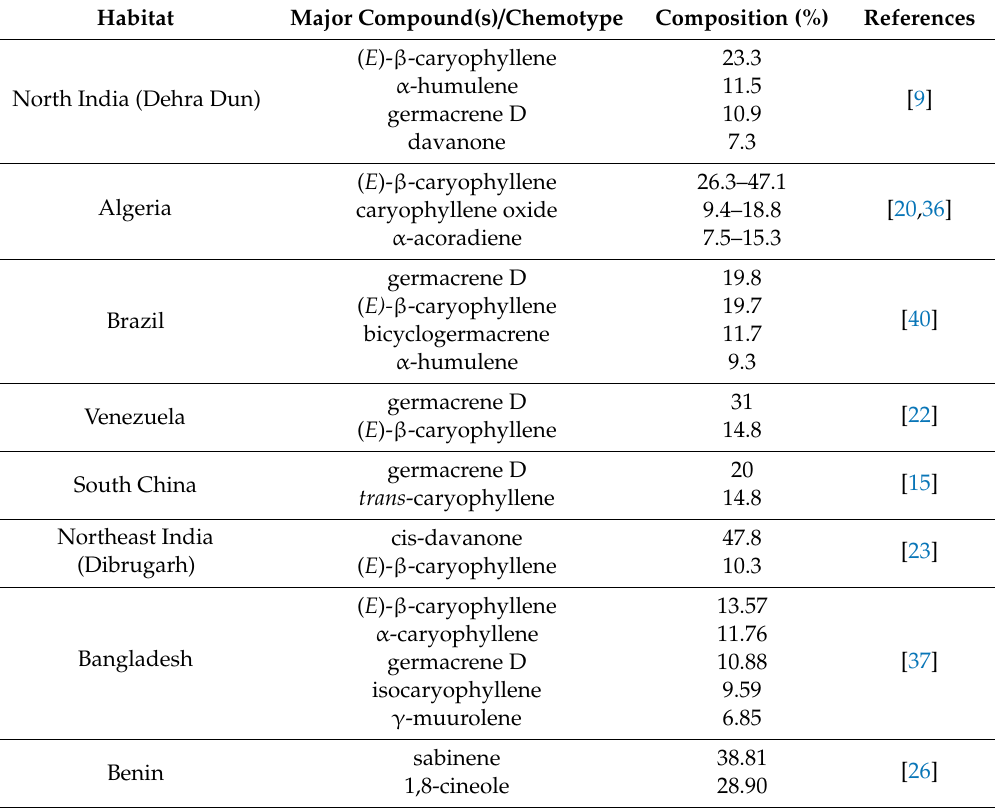
Table 5. Major compounds of L. camara leaf essential oils from some countries. Habitat Major Compound(s) / Chemotype Composition